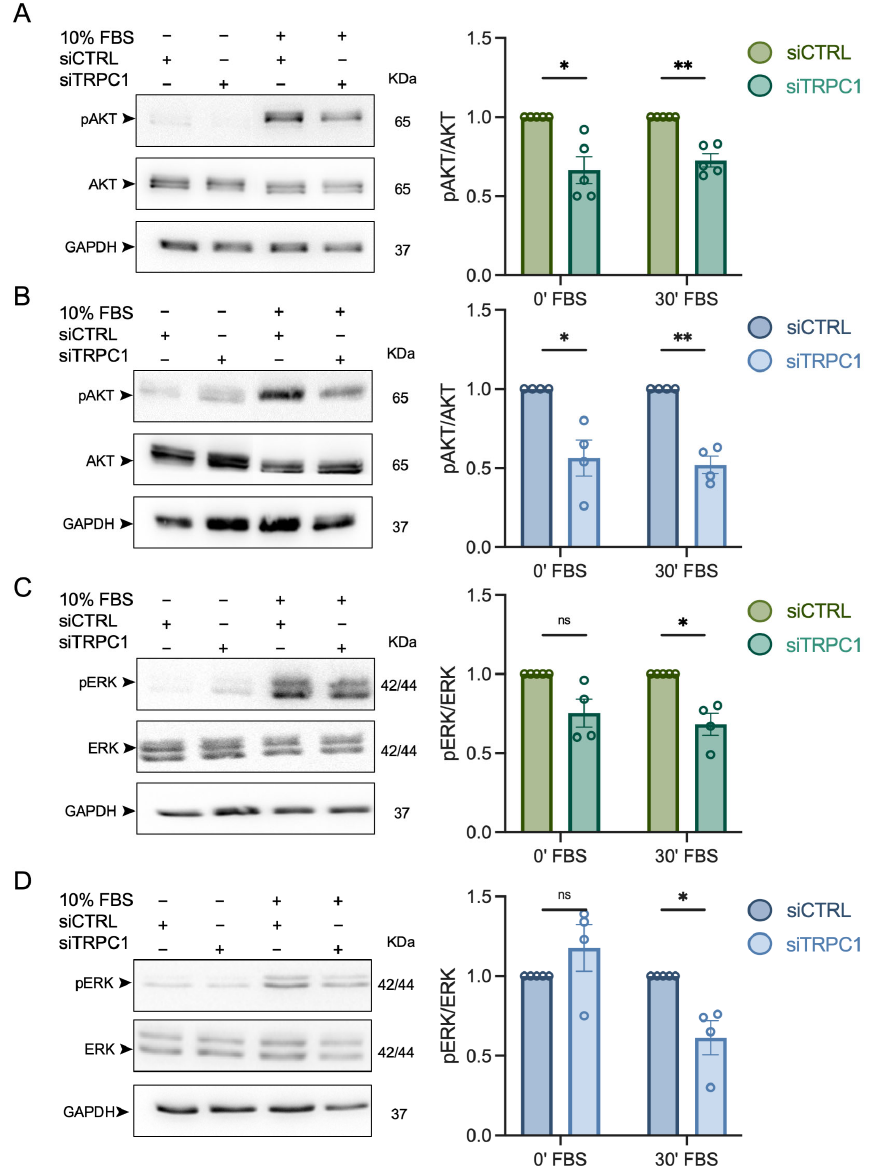
Figure 8. TRPC1 silencing inhibits the phosphorylation of AKT and ERK1/2, notably in acid recovery conditions. ( A ) Western blot analysis of phosphorylated AKT (pAKT) and total AKT in transfected PANC-1 cells grown in acid adaptation (6.5) conditions or ( B ) in acid recovery (7.4R) conditions after mitogen activation with FBS for either 0 or 30 min (left panel). Quantification of the Western blot analysis compared to siCTRL either after 0 min or 30 min of mitogen activation (right panel). ( C ) Western blot analysis of phosphorylated ERK1/2 (pERK1/2) and total ERK1/2 in transfected PANC-1 cells grown in acid adaptation (6.5) conditions or ( D ) in acid recovery conditions (7.4R) after mitogen activation with FBS for either 0 or 30 min (left panel). Quantification of the Western blot analysis compared to siCTRL either after 0 min or 30 min of mitogen activation (right panel). Welch’s correction t ‐ test was used to determine the significant difference between siCTRL and siTRPC1. ns indicates non ‐ significance. * and ** indicate p < 0.05 and 0.01, respectively. The uncropped blots are shown in File S1.